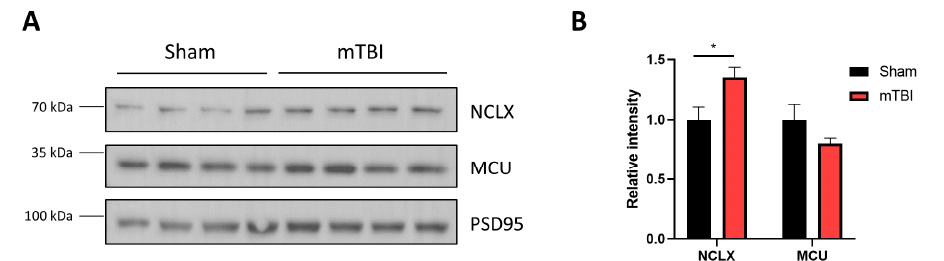
Figure 6. mTBI increases NCLX protein levels in synaptic mitochondria. ( A ) Immunoblot of mito- chondrial proteins contained in synaptosomes. It shows NCLX and MCU. PSD-95 was used as a loading control. ( B ) Quantification of NCLX and MCU. n = 4. * p < 0.05.